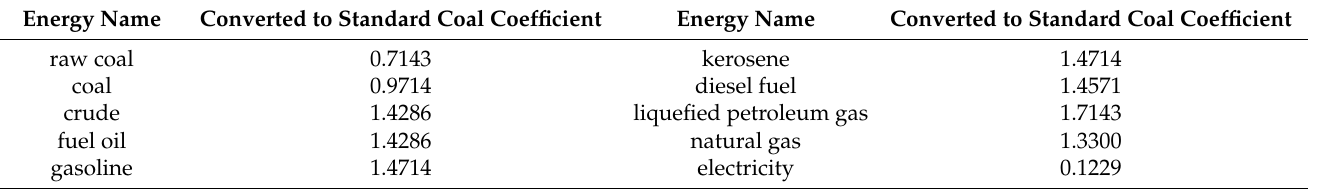
Table 1. Conversion coefficients of standard coal for various energy